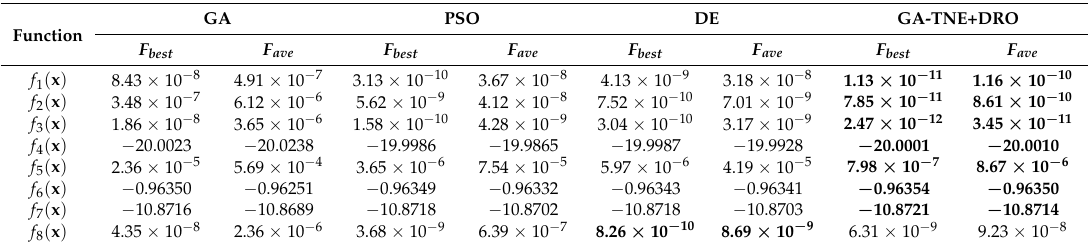
Table 4. The optimal values of objective functions obtained by the algorithms (the best obtained results are highlighted in bold).